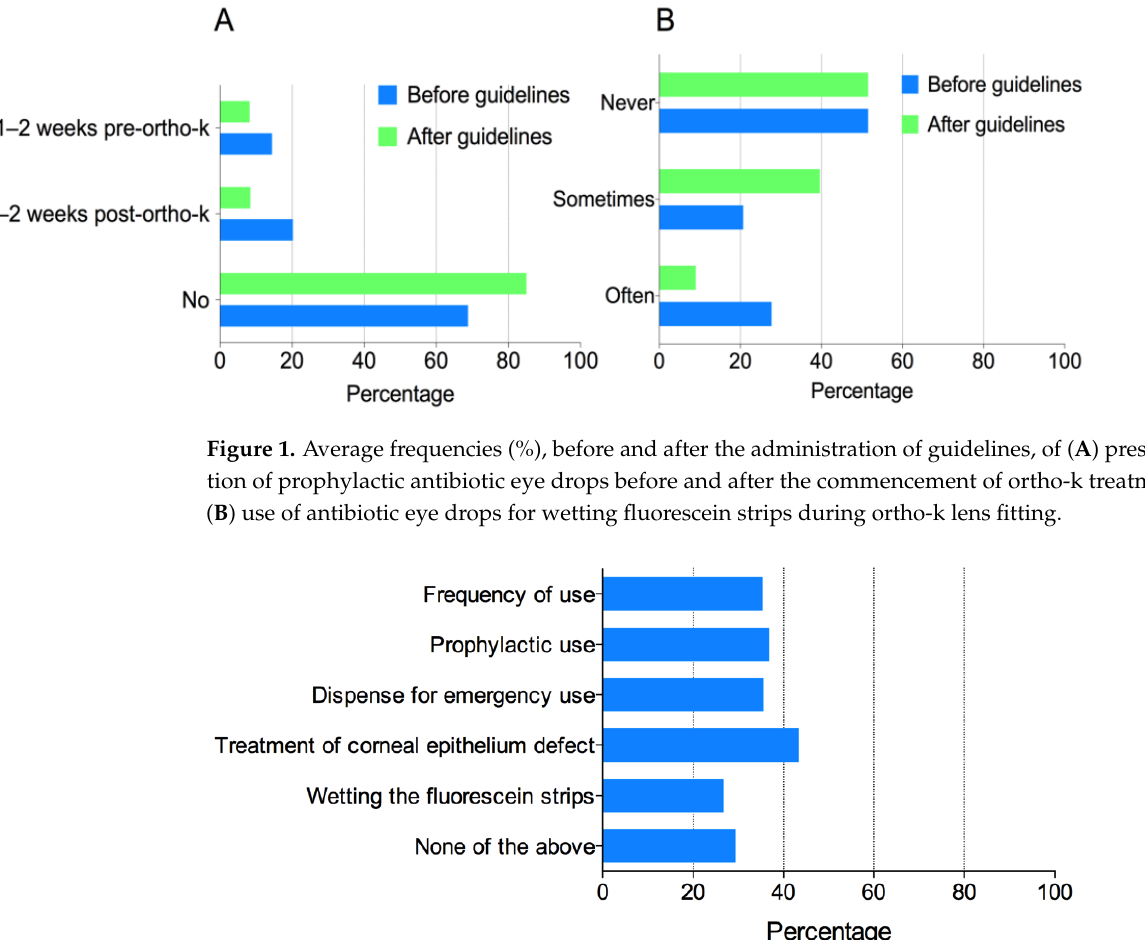
Figure 3. What is the most common misuse of antibiotic eye drops in your orthokeratology patients?